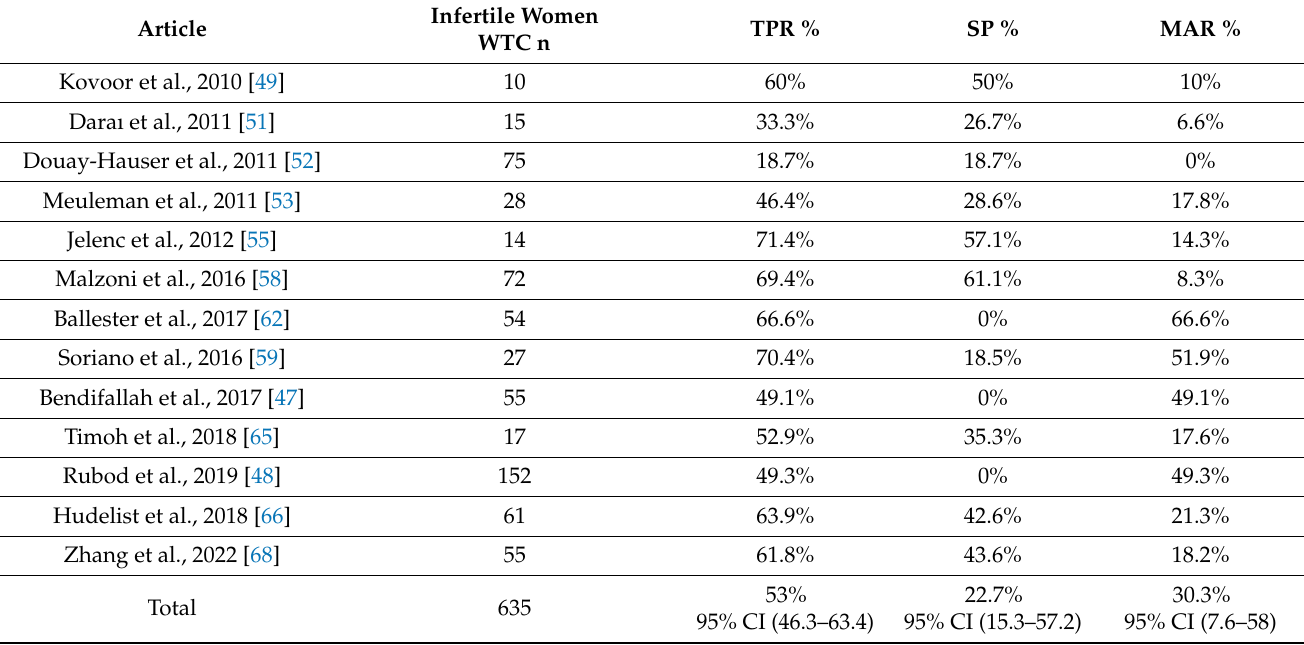
Table 2. Pregnancy rates in infertile women